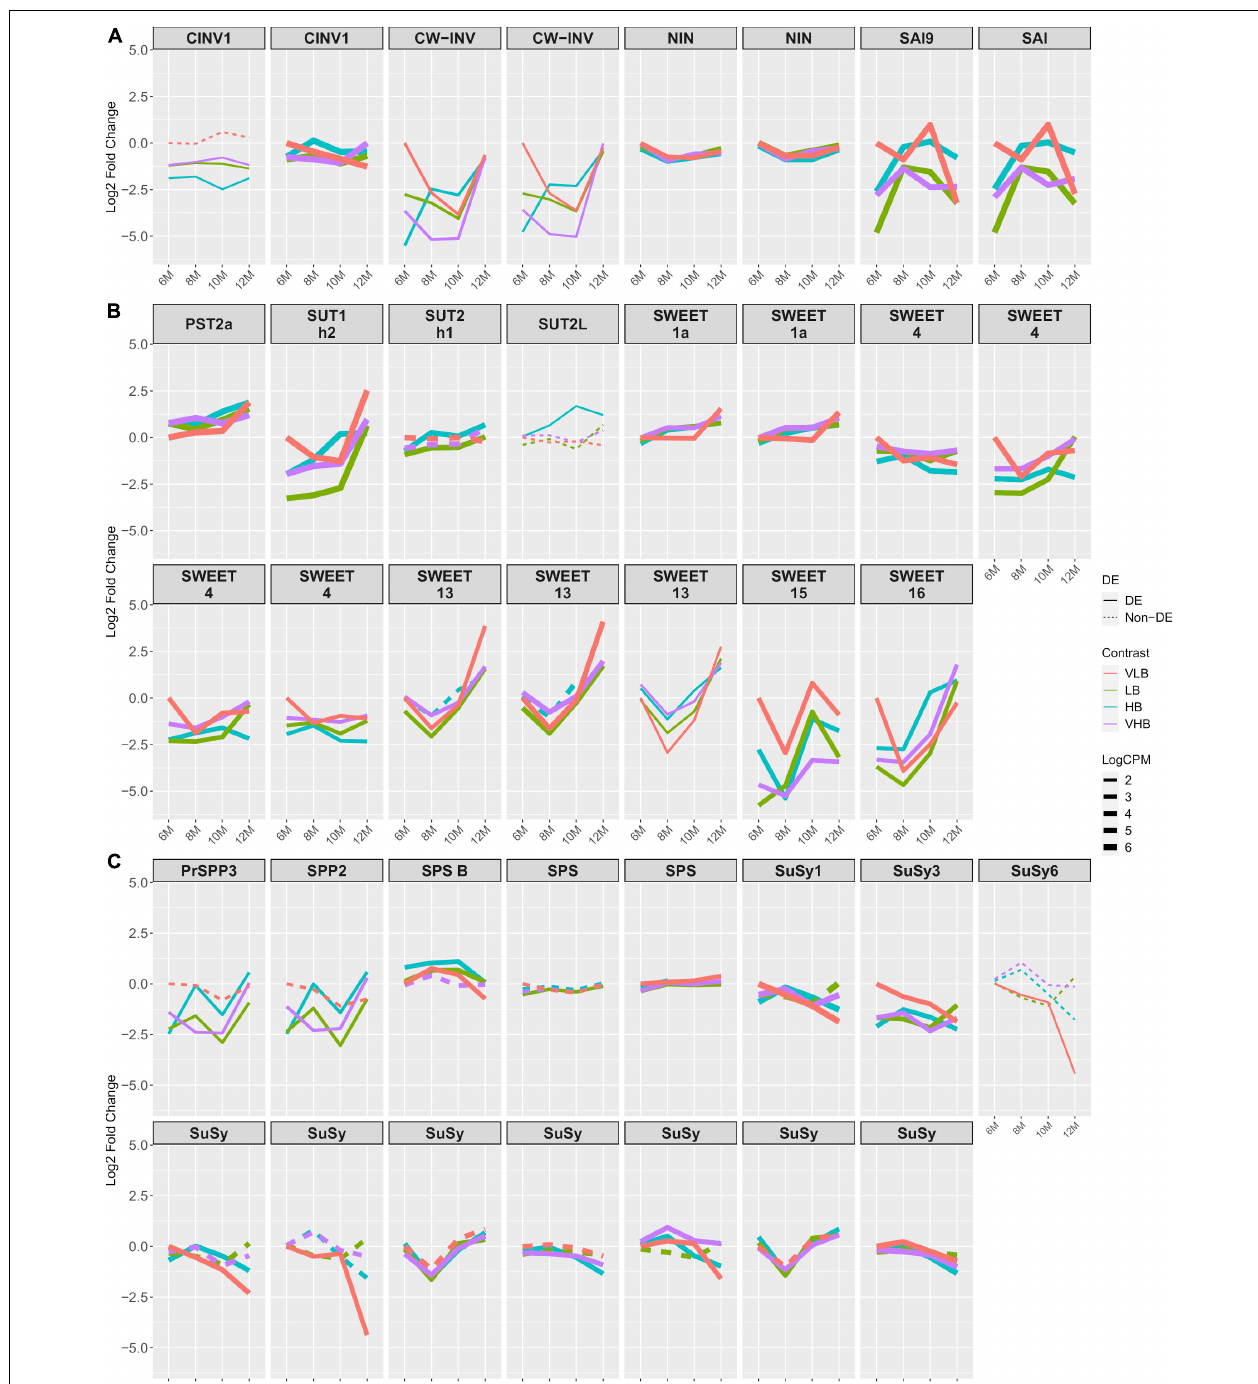
FIGURE 2 | Expression profiles of genes related to sucrose metabolism. The x axis shows the age of plants (in months). The y axis corresponds to the log fold change in comparison to the very low ◦ Brix (VLB) genotype in T1 (6-month-old plants). Each line represents a gene and the solid lines indicate genes with significant differential expression in at least at one time point, while dashed lines represent genes with no differential expression for a given genotype. The line width indicates the average expression level of each gene, with more highly expressed genes thicker. (A) Invertase genes, where CINV, CW-INV, NIN, and SAI correspond to cytosolic invertase, cell wall invertase, alkaline/neutral invertase and soluble acid invertase, respectively. (B) Genes responsible for sugar transport, with PST, SUT and SWEET corresponding to putative sugar transporter, sucrose transporter and bidirectional sugar transporter SWEET, respectively. (C) Genes involved in sucrose metabolism, where PrSPP, SPP, SPS and SuSy correspond to probable sucrose phosphate phosphatase, sucrose phosphate phosphatase, sucrose phosphate synthase and sucrose synthase, respectively. VLB: very low ◦ Brix, LB: low ◦ Brix, HB: high ◦ Brix and VHB: very high ◦ Brix.